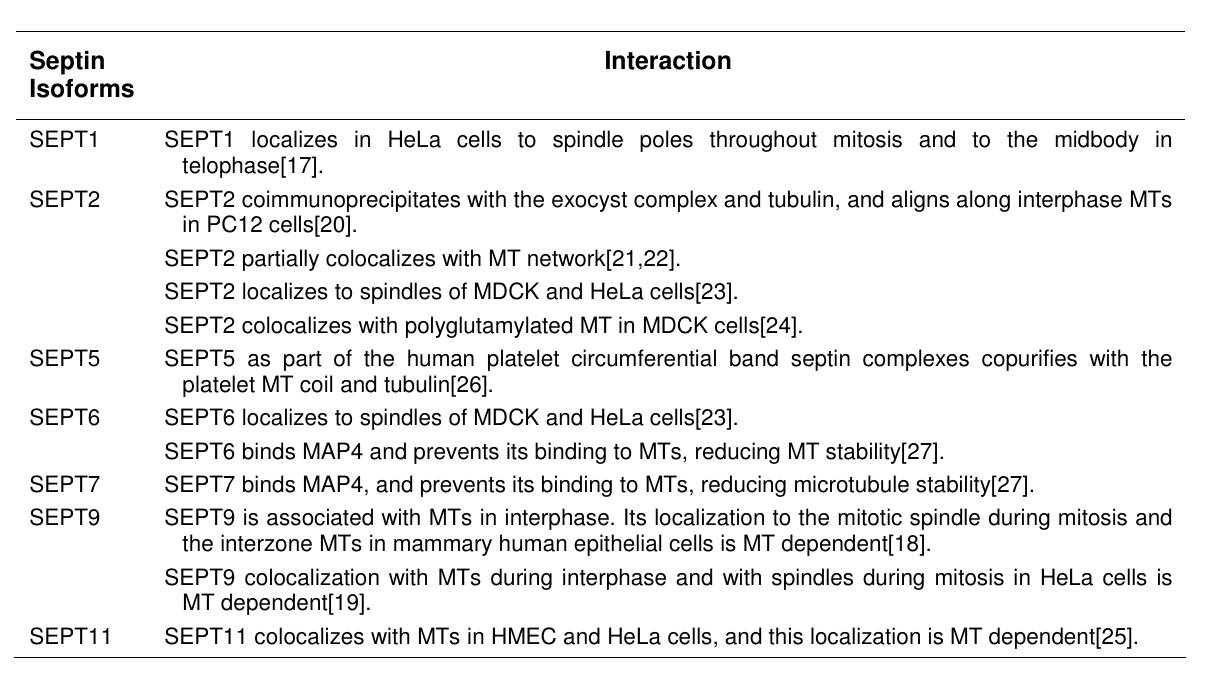
Interaction of Mammalian Septins with the MT